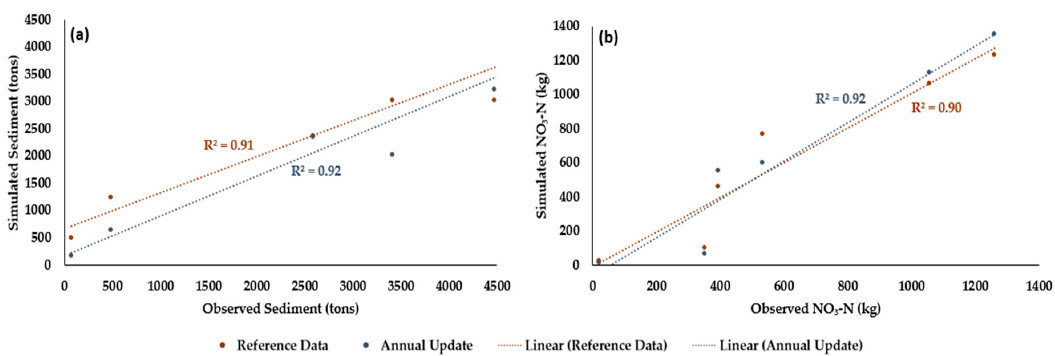
Figure 10. Comparison between observed and simulated monthly (second semester 2019) ( a ) sediment load to Zazari Lake and ( b ) NO 3 -N loads to Zazari Lake .